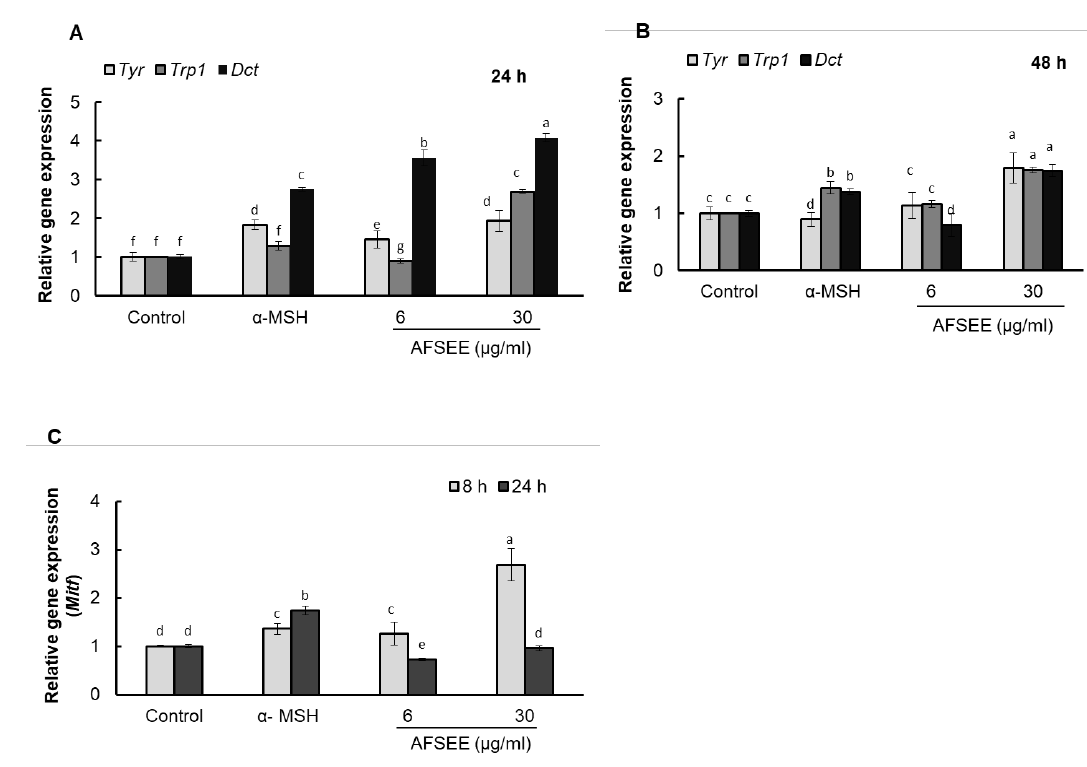
Figure 6. Effect of argan fruit shell ethanol extract (AFSEE) on tyrosinase ( Tyr ), tyrosinase-related protein 1 ( Trp1 ), dopachrome tautomerase ( Dct ), and microphthalmia-associated transcription factor ( Mitf ) mRNA expression. B16F10 cells were cultured in a 100 mm dish at a density of 3 × 10 5 cells/dish and treated without (control) or with α-MSH (200 mM) or AFSEE (6 µg/mL and 30 µg/mL). The expression level of Tyr , Trp1, and Dct mRNA expression were quantified using TaqMan real-time PCR ( A ) following treatment without (control) or with α-MSH or AFSEE for 24 h and ( B ) following treatment without or with α-MSH or AFSEE for 48 h. ( C ) The effect of AFSEE on Mitf expression was quantified using TaqMan real-time PCR following treatment without or with α-MSH or AFSEE for 8 h and 24 h. Data was subjected to ANOVA ( n = 3). All comparisons were made between treatments. Different letters indicate treatment differences at the p ≤ 0.05 level.